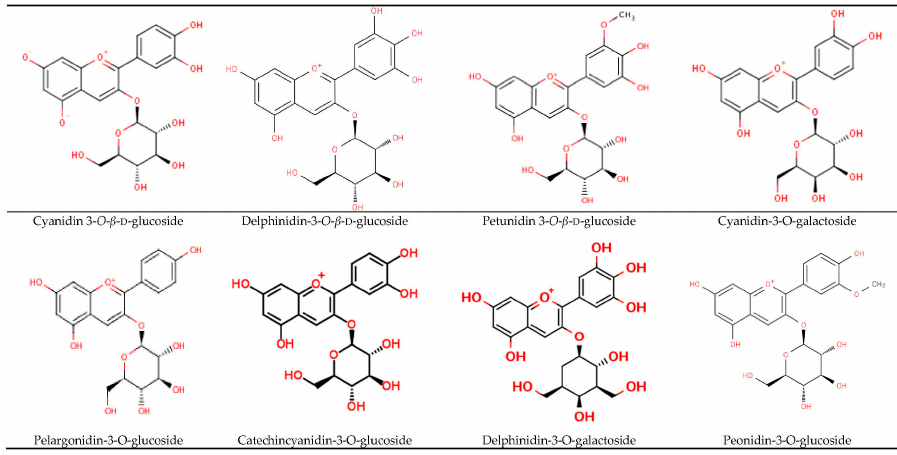
Figure 2. Anthocynins isolated from back soybean [45–47].